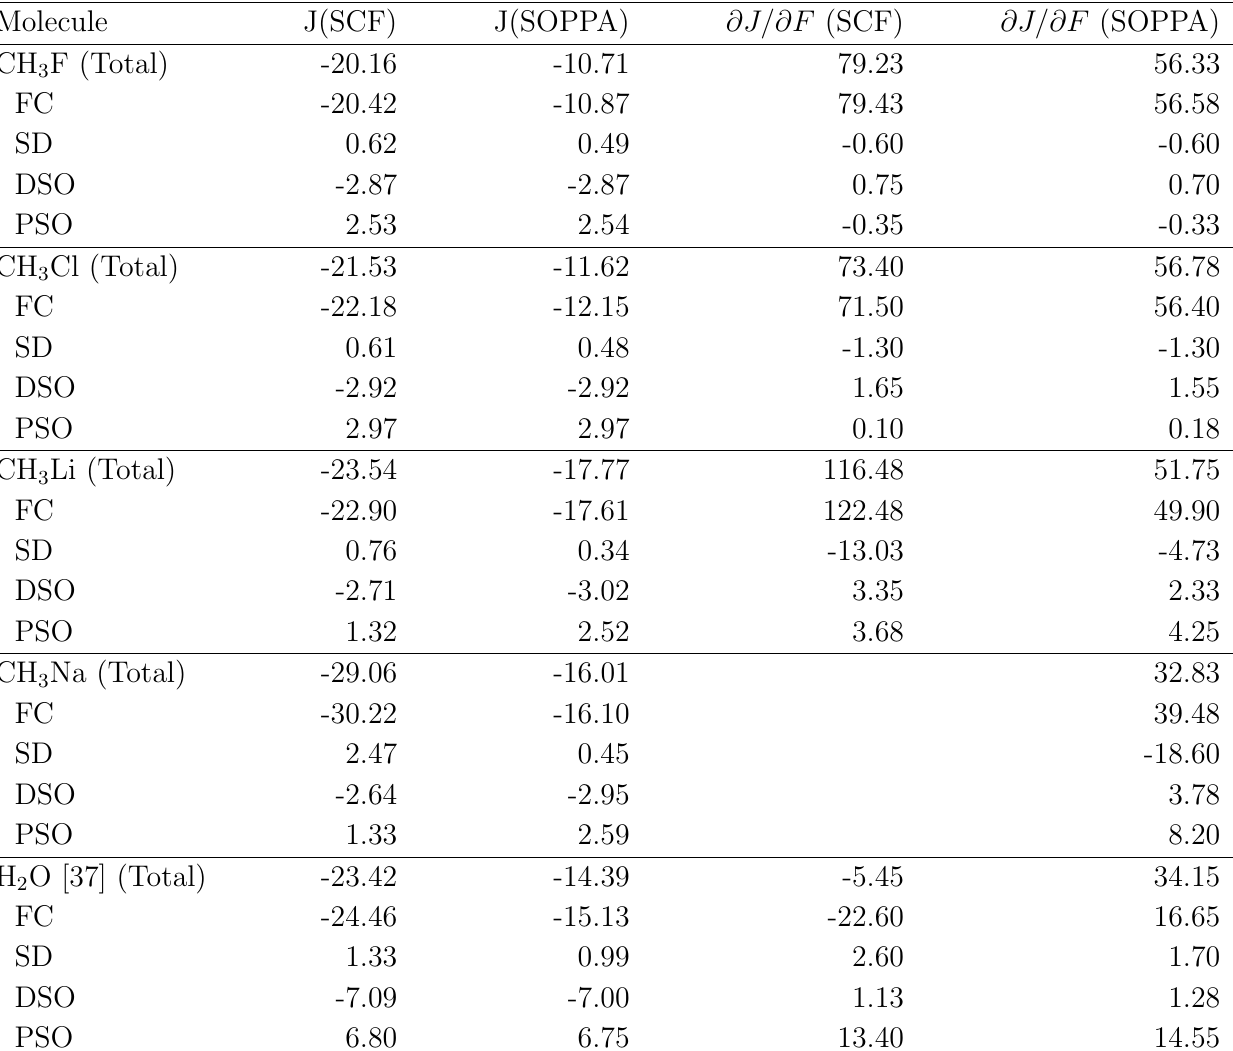
Table 2. Table of the Breakdown into Terms FC, SD, DSO and PSO (All Js and components are in units of Hz, and derivatives in Hz / au. 1 au (Electric Field) = 5.14220 V m − 1